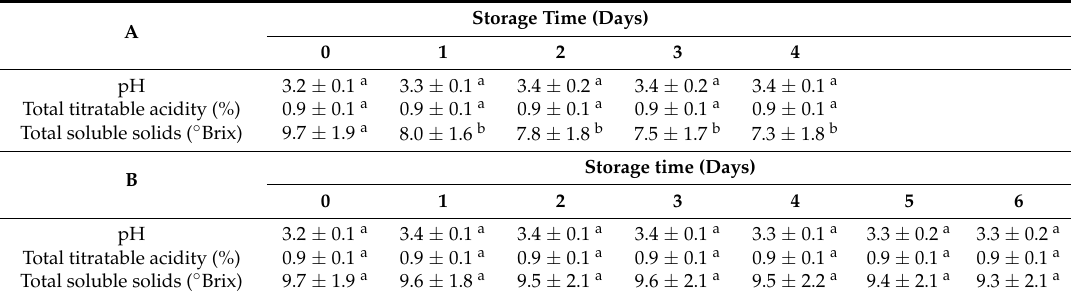
Table 1. Evolution of the pH, total titratable acidity, and total soluble solids of tchapalo stored at ( A ) ambient temperature (28 to 30 ◦ C) for four days and ( B ) 4 ◦ C for six days. Storage Time A